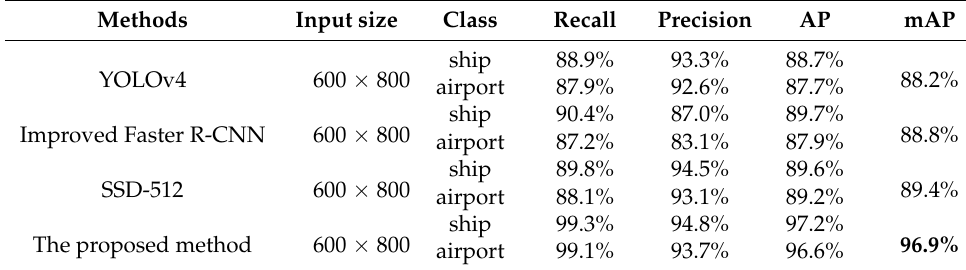
Table 5. Comparison with target detection algorithms in the optical field.